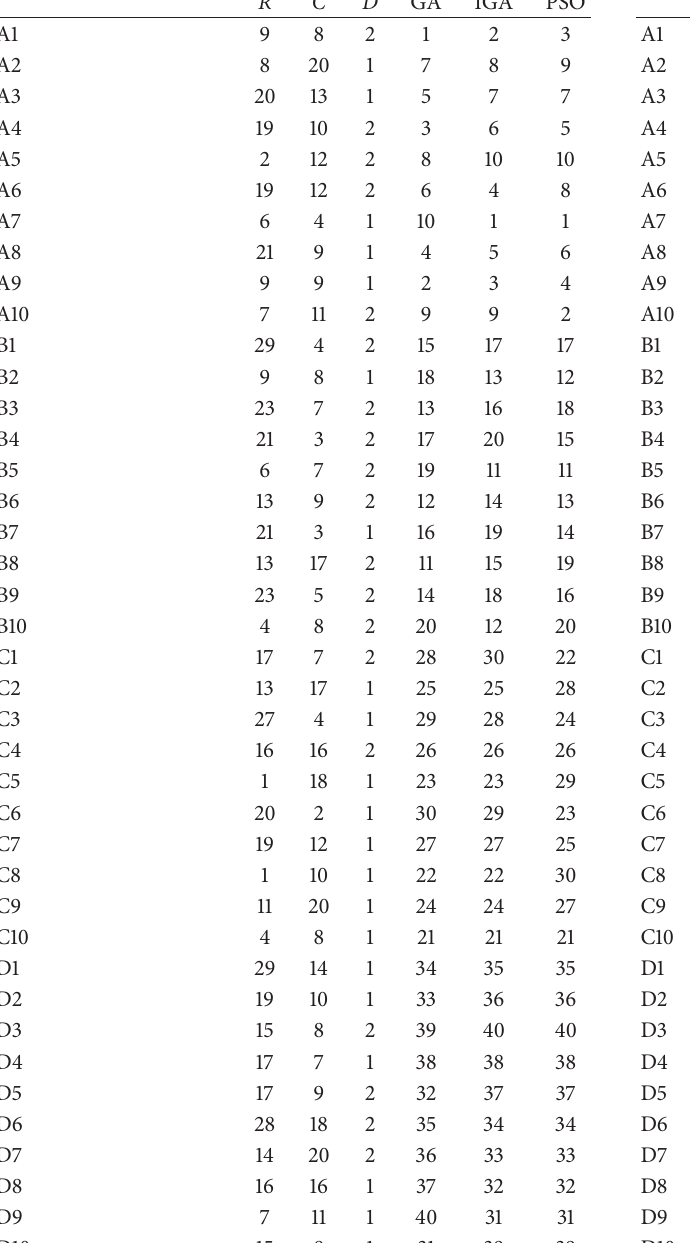
Table 4: The addresses of the stored cargo for simulation in Case 4. Type and number of